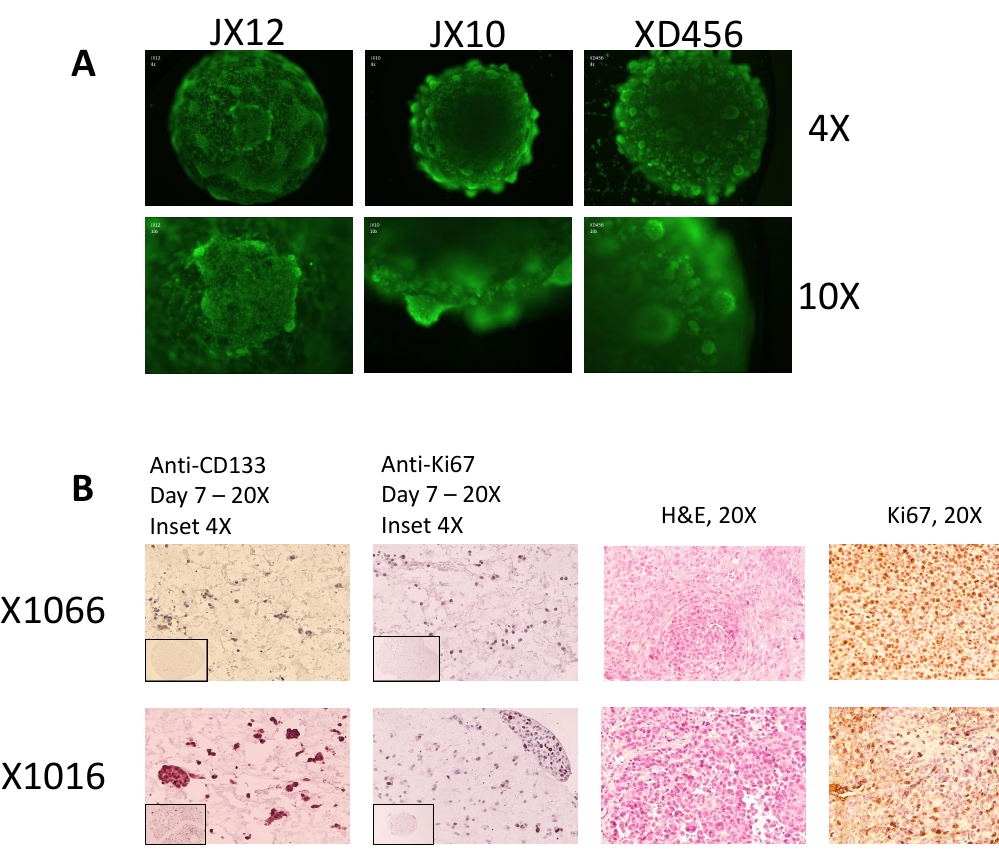
Figure 2. Representative images and staining of derivative microtumors: ( A ) calcein acetoxymethyl ester (AM) imaging of microtumors; ( B ) (left) IHC, anti-CD-133 staining of microtumors, (center-left) IHC, anti-Ki-67 staining of microtumors, (center-right) H&E staining of matched orthotopic patient-derived orthotopic xenografts (PDX) tumor, (right) IHC, anti-Ki-67 staining of matched orthotopic PDX